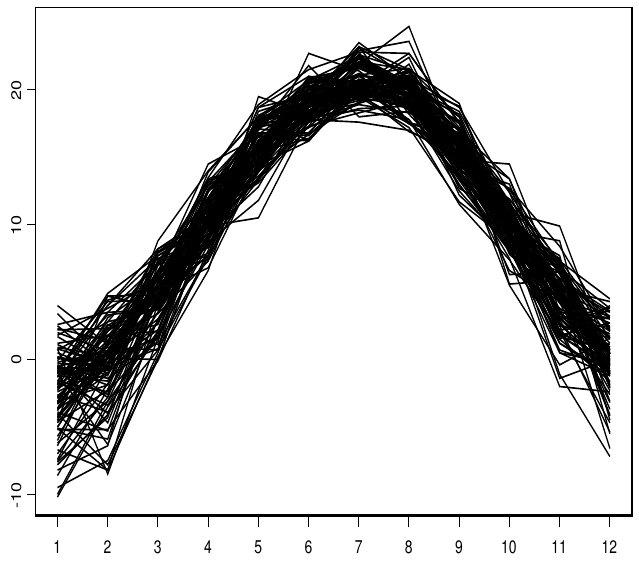
Figure 2. Mean temperature by